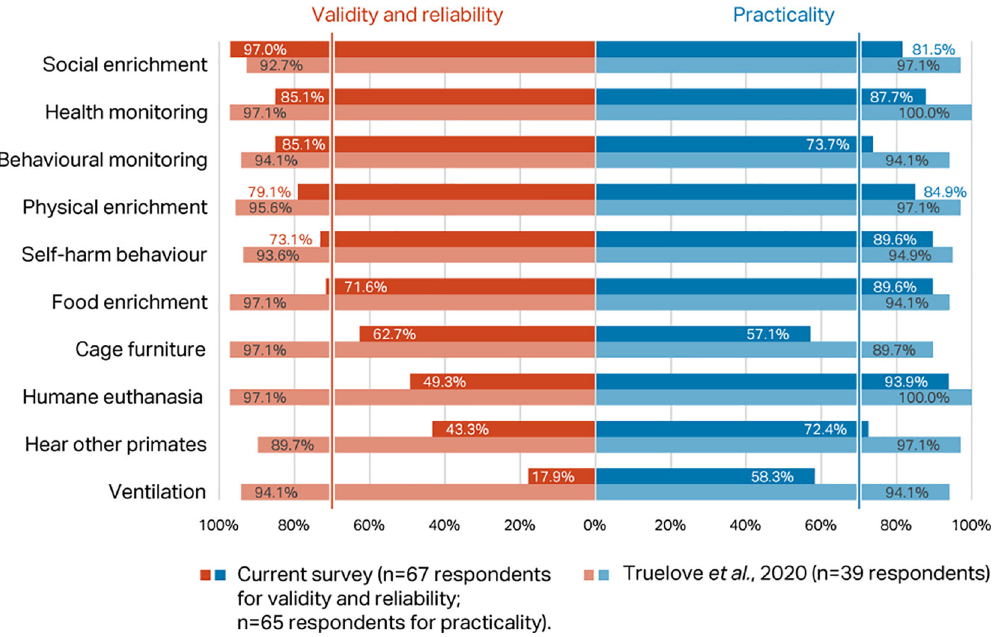
Figure3.Comparisonofvalidityandreliabilityandpracticabilityscores(percentageofrespondents)between the two Delphi consultations for macaques, showing the top ten indicators identified inTruelove etal . (2020).